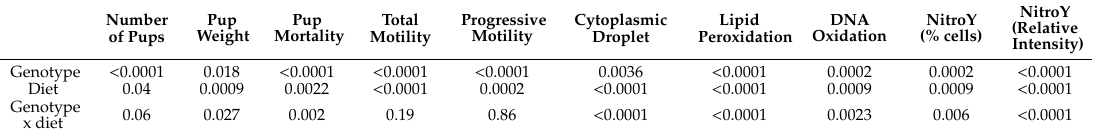
Table 2. Complete summary ( p -values) of statistical analysis by two-way